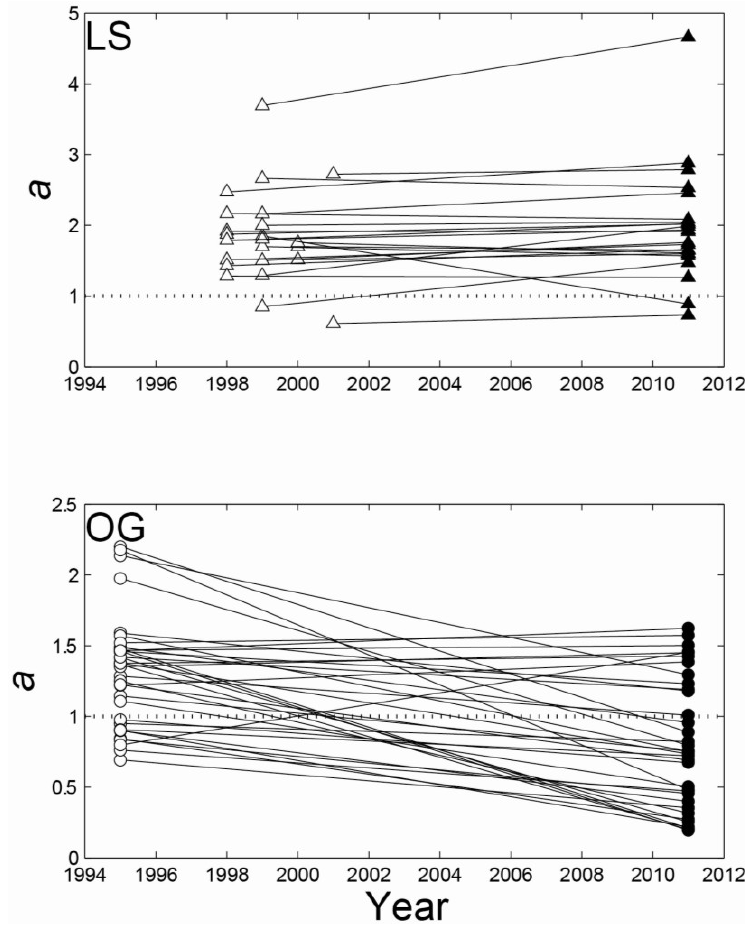
Figure 4. Change in the shape parameter a of the Weibull distribution for late-successional (LS) and old-growth (OG) plots; the special case of the exponential distribution ( a = 1) is shown as a dashed line for reference.